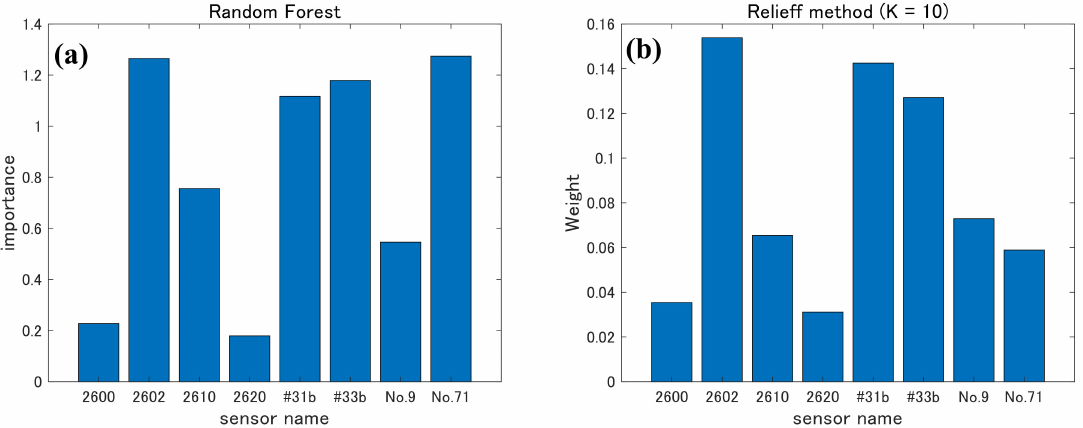
Figure 8. Weights given to results of each sensor obtained by ( a ) random forest and ( b )